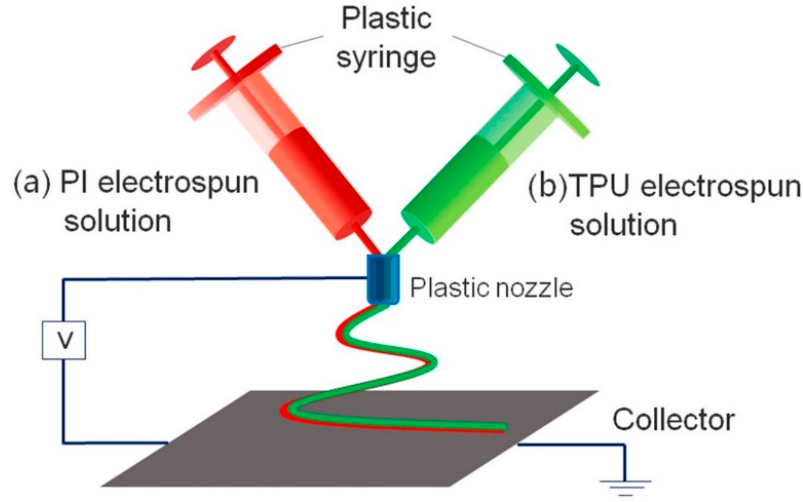
Figure 1. Apparatus schematic of side-by-side electrospinning.